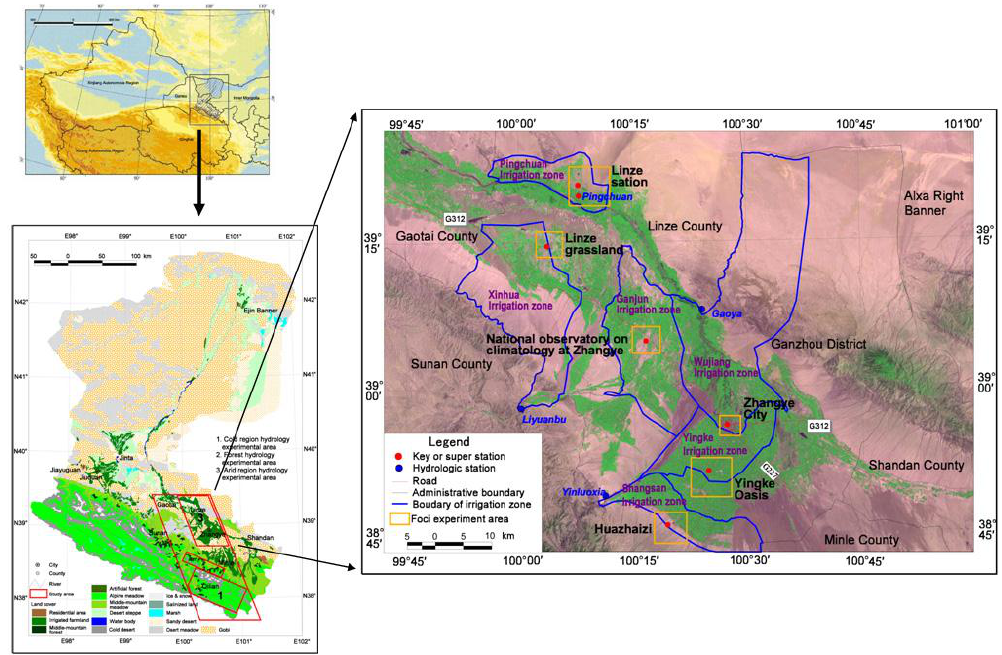
Fig. 1. Locations of the Linze grassland in the arid region hydrology experiment area (right) in the Heihe River Basin (bottom left).